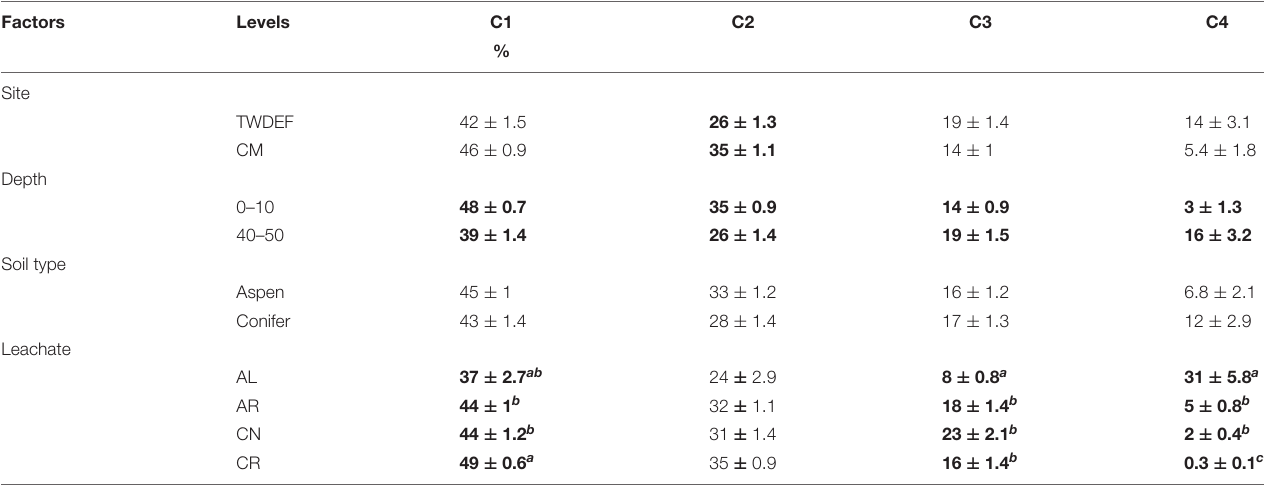
TABLE 6 | Average values ± standard error of calculated fluorescence parameter proportions for each level of each main effect (Bolding indicates statistically significant differences at α = 0.05; letters indicate differences between levels of a factor).